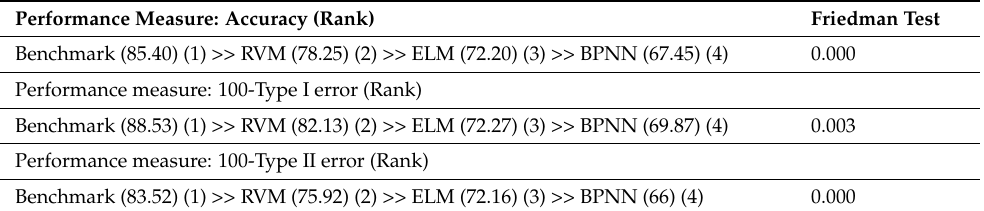
Table 9. The outcomes of comparison.